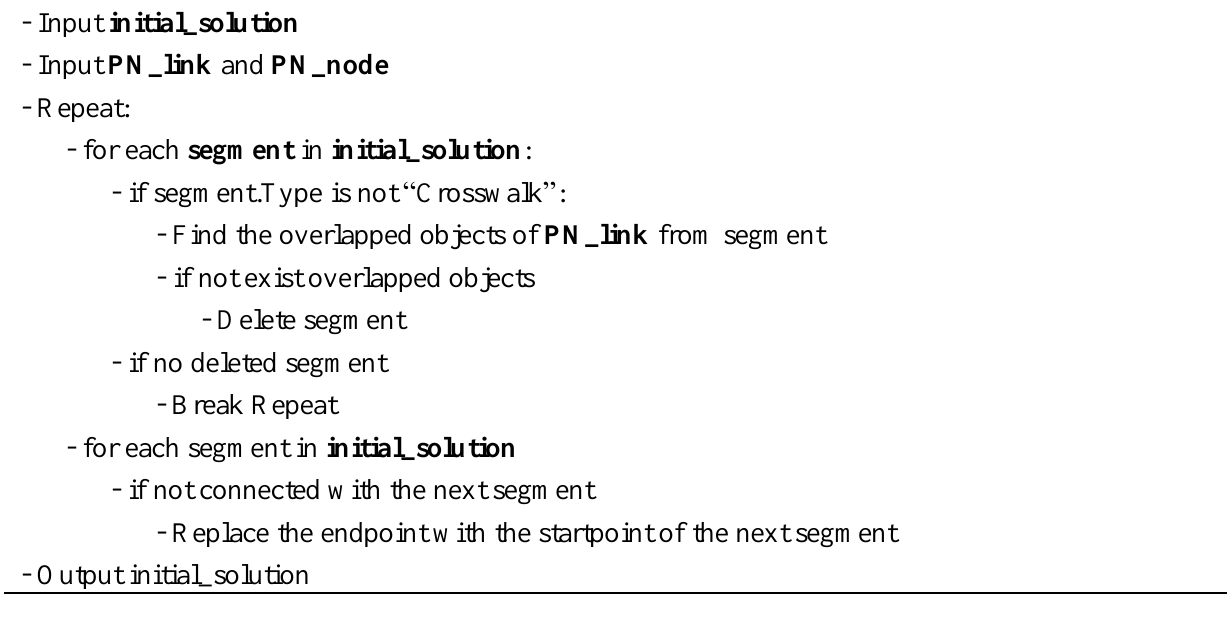
Algorithm 1 Correcting errors on dual-lined segments